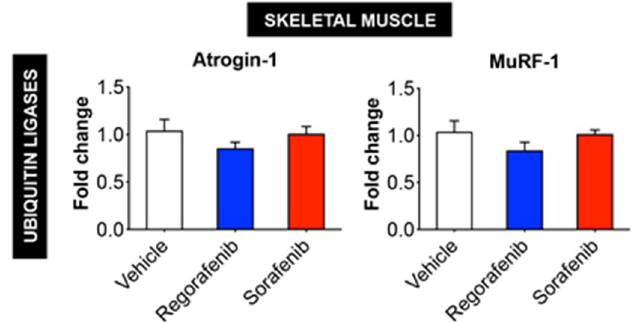
Figure 5. Expression of ubiquitin ligases Atrogin-1 and MuRF-1 in skeletal muscle is not affected by MKIs. mRNA expression for Atrogin-1 and MuRF-1 in the skeletal muscle of mice treated with 30 mg/kg/day regorafenib (blue; n = 8), 60 mg/kg/day sorafenib (red; n = 8), or vehicle (white; n = 8) over the course of 6 weeks. Data presented as mean ± SEM.